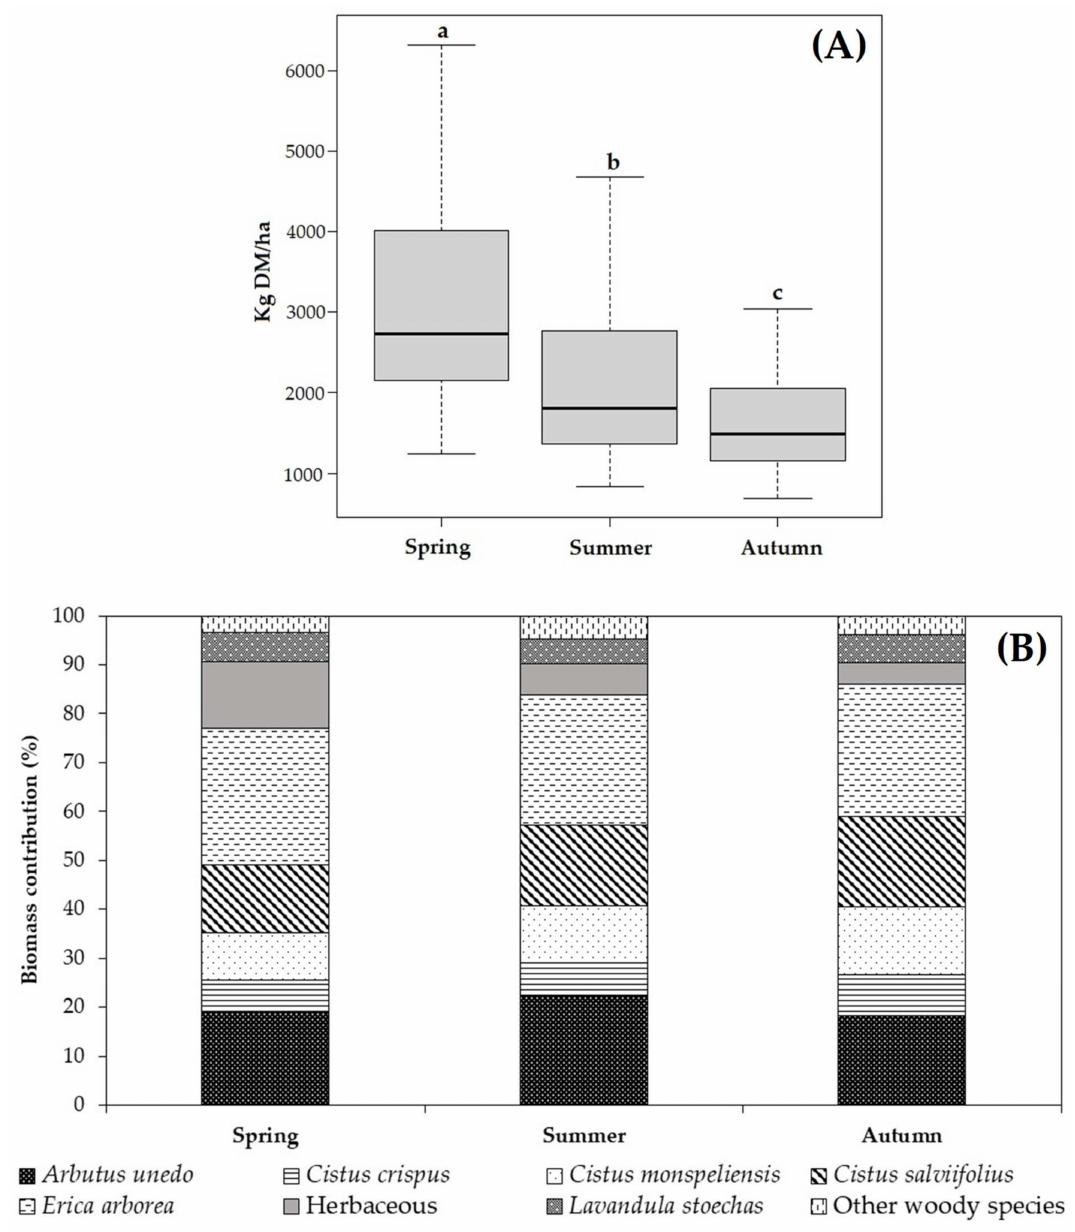
Figure 9. Forage availability ( A , Kg DM/ha) and contribution (%) of each palatable plant species ( B ) in forest rangelands of Northern Morocco. Different letters (a–c) are significantly different ( p <